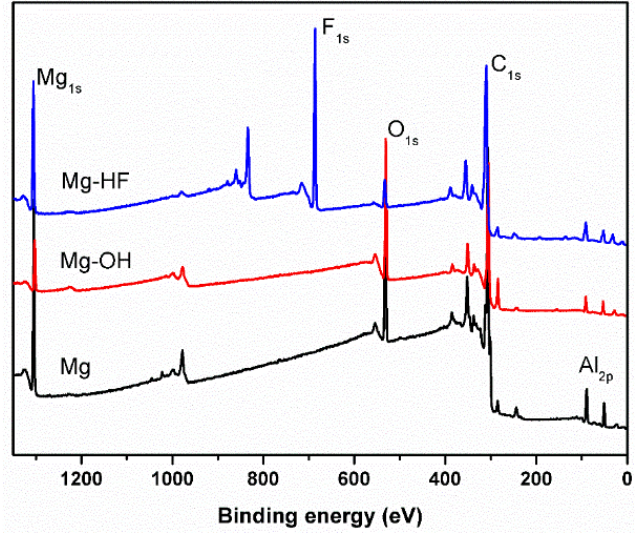
Table 1. X-ray photoelectron spectroscopy (XPS) surface atom percentage of different samples (wt %).